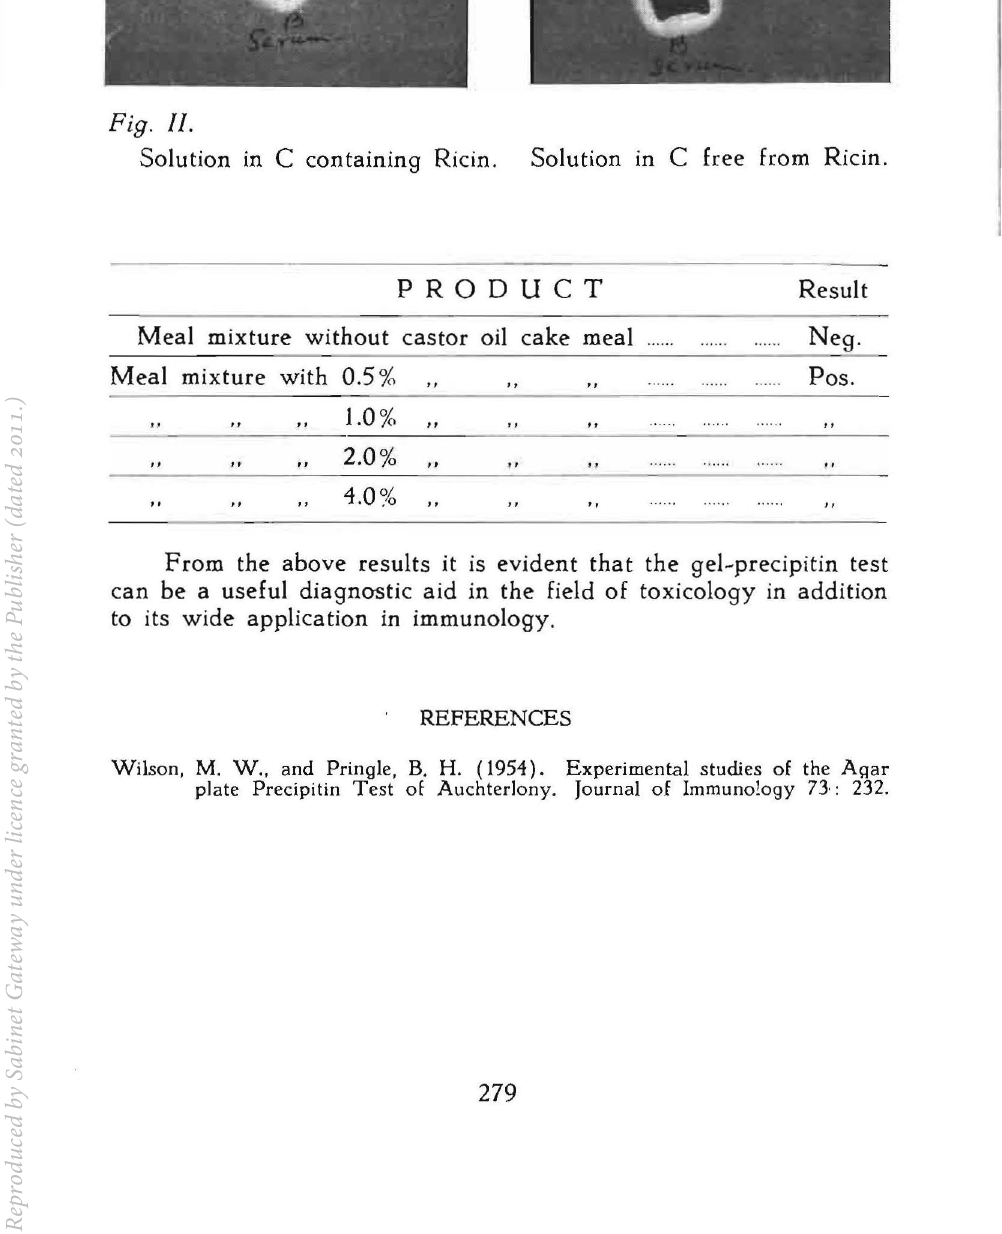
Fig. II. Solution in C containing Ricin. Solution in C free from Ricin.